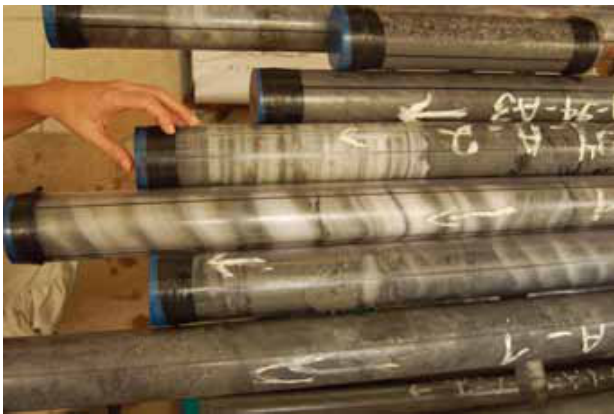
Figure 2. Drill cores in liners recovered at depth around 300 m below lake floor. From top to bottom the cores show change from gravel (top core) to marls interlaced with fine-grained salt layers (middle cores). This suggests that at that time the shore was very close to the drilling site, and the wavy salt patterns were interpreted as a result of salt flow.